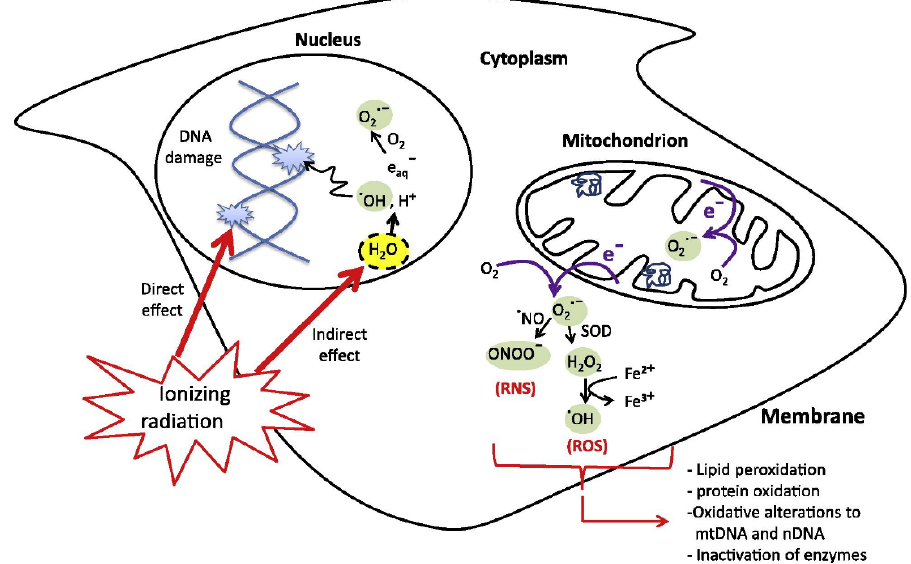
Figure 1. The direct and indirect cellular effects of ionizing radiation on macromolecules. Absorption of ionizing radiation by living cells directly disrupts atomic structures, producing chemical and biological changes and indirectly through radiolysis of cellular water and generation of reactive chemical species by stimulation of oxidases and nitric oxide synthases. Ionizing radiation may also disrupt mitochondrial functions significantly contributing to persistent alterations in lipids, proteins, nuclear DNA (nDNA) and mitochondrial DNA (mtDNA). Reproduced from Cancer letters 2012 , 327 , 48–60 [73]. Copyright Elsevier 2012.